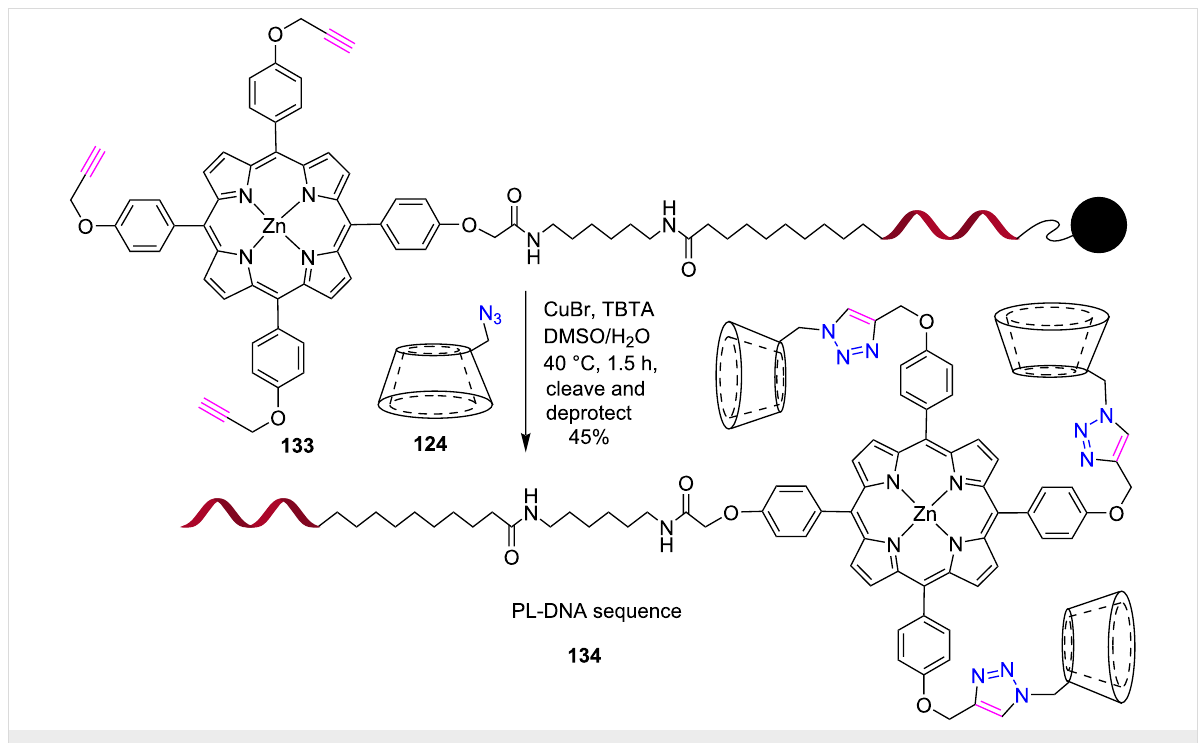
Scheme 27: Synthesis of tritriazole-bridged porphyrin-lantern-DNA sequence 134 .